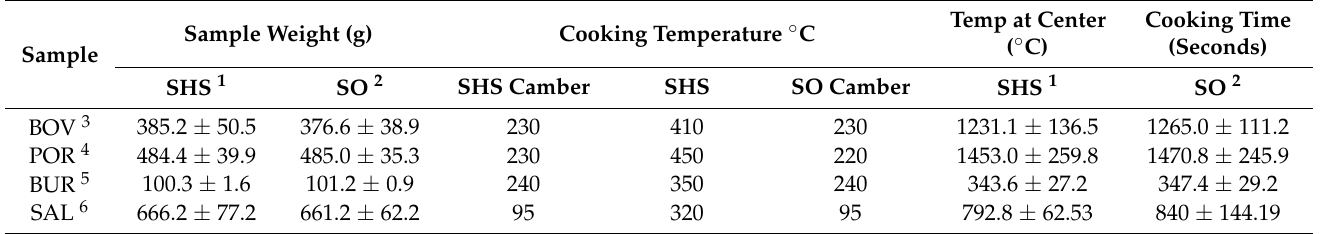
Table 1. Experimental